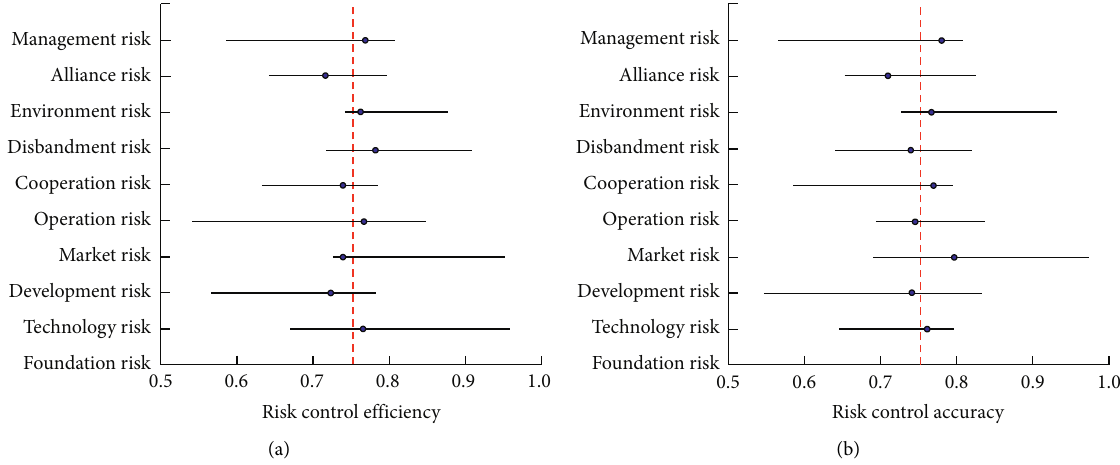
Figure 6: Risk control efficiency (a) and accuracy (b) of different risk types of virtual enterprise.